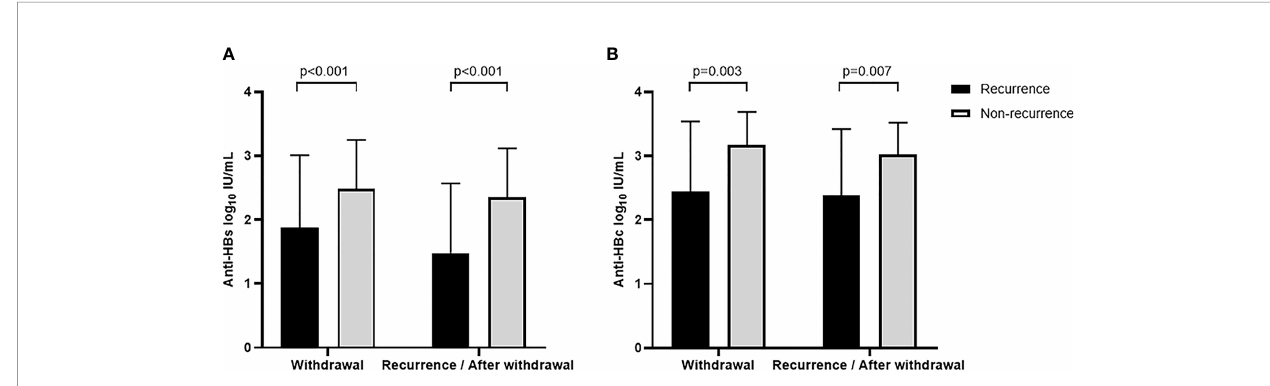
FIGURE 2 | Anti-HBs (A) and anti-HBc (B) levels at different time points between recurrence and non-recurrence groups.